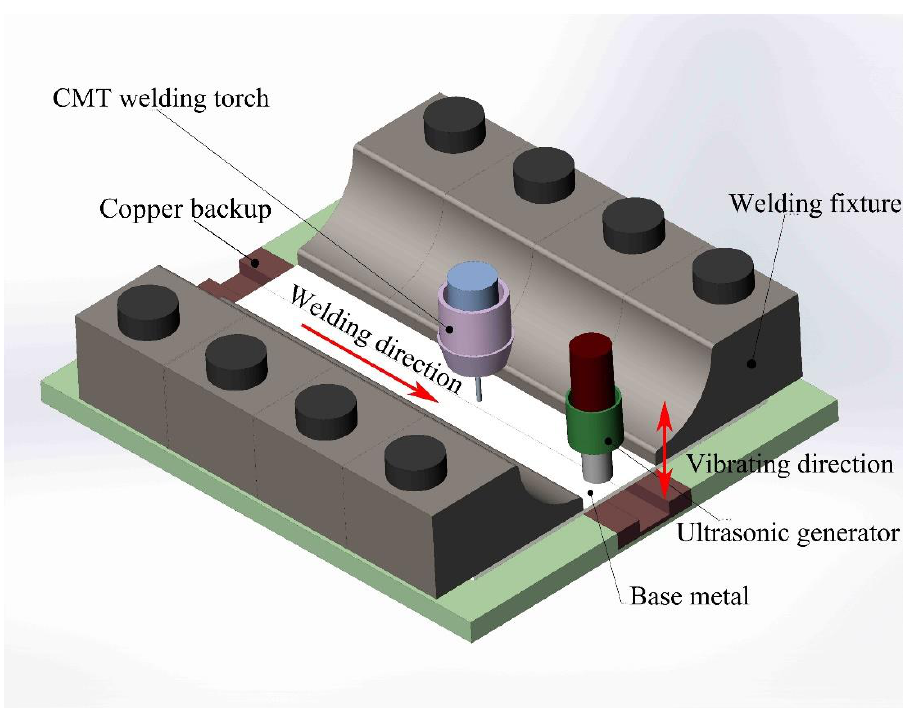
Figure 1. Schematic of ultrasonic vibration-assisted CMT